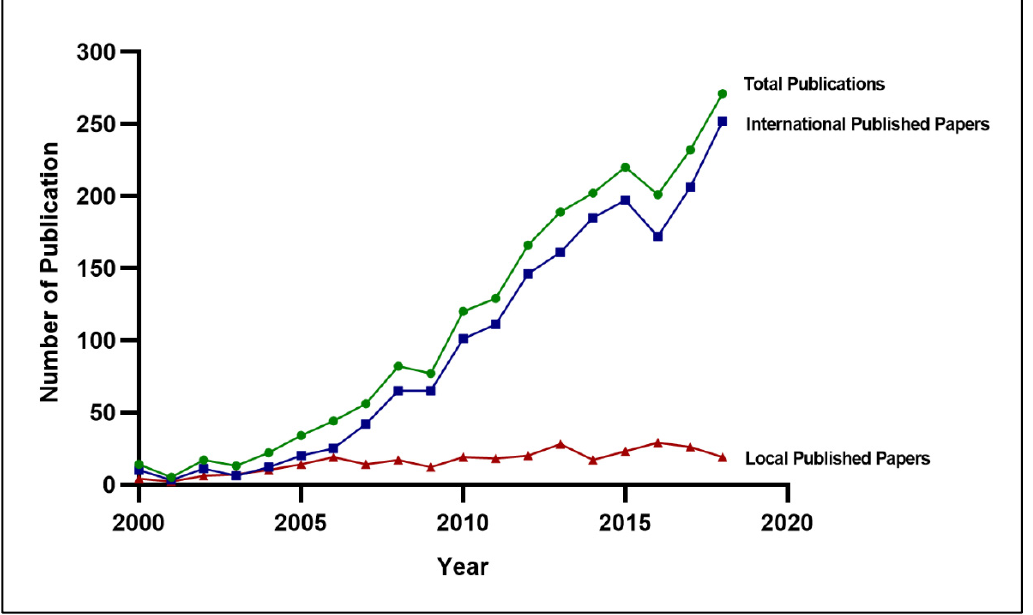
Figure 2. Trend of diabetes research productivity from 2000–2018 in Malaysia ( n = 2094).